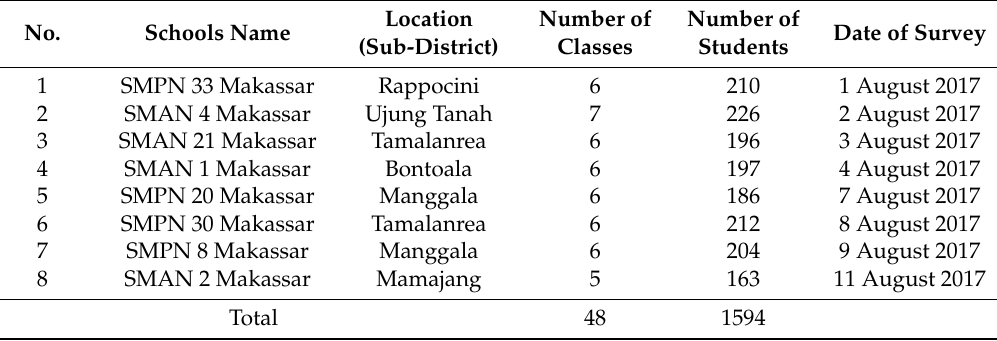
Table 1. The number of classes and students (respondents) of each